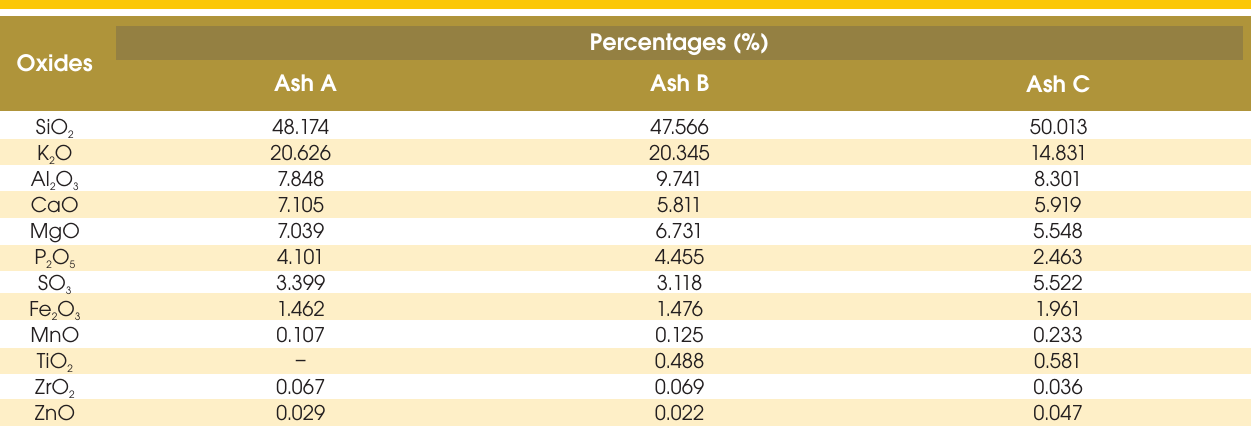
Table 4 – Chemical composition of SBA by XRF (equivalent